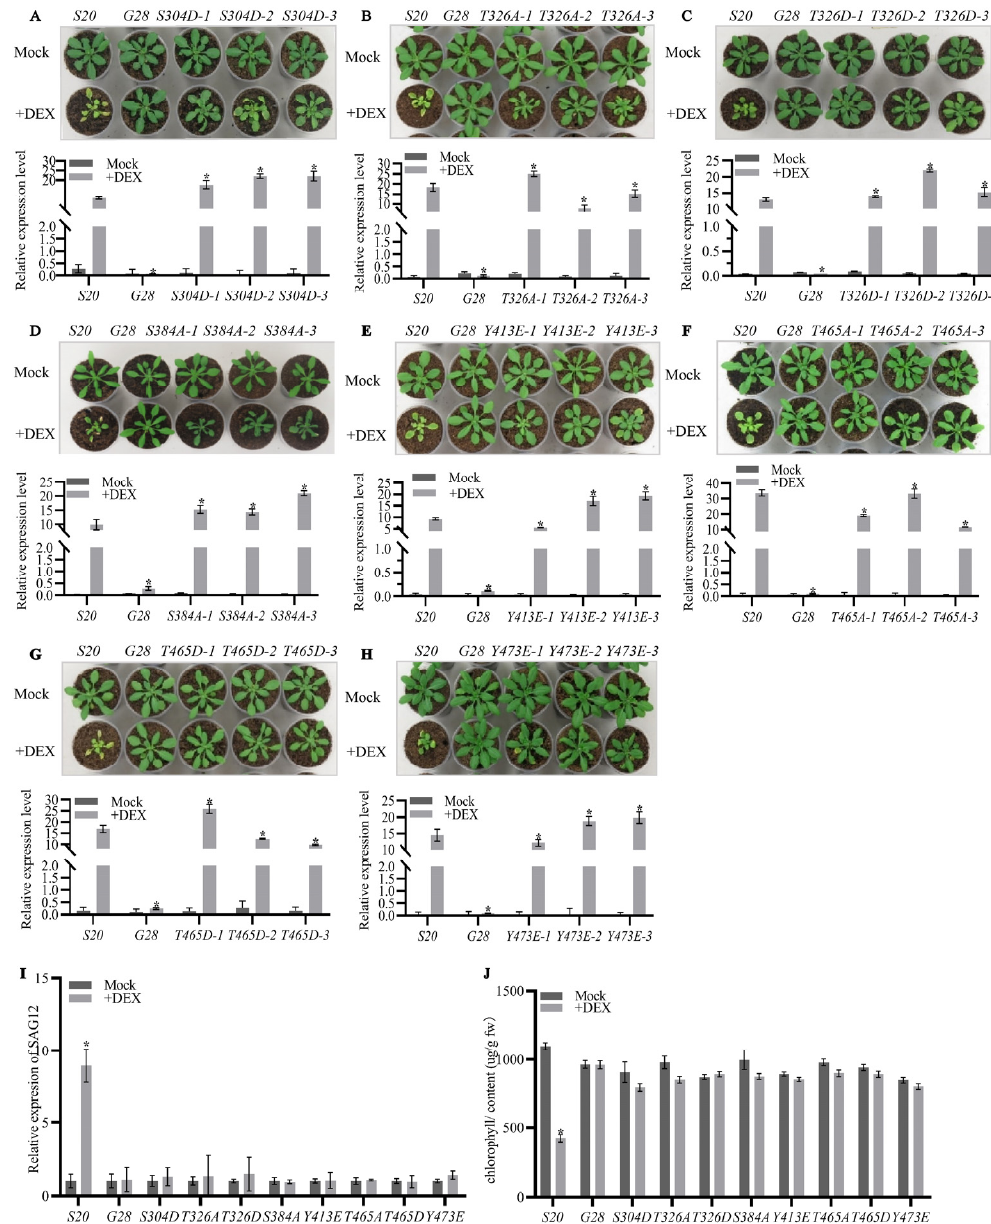
Figure 3. The autophosphorylation of AtSARK is essential for its function in promoting leaf senescence. Three independent lines of 19-d-old transgenic Arabidopsis overexpressing the indicated site-directed mutant of AtSARK under the control of GVG promoter were daily sprayed with dexamethasone (DEX) or its mock solvent as described in Section 4 and the photographs were taken after an additional 7 d (upper, A – H ). The GVG:AtSARK ( S20 ) and GVG:GUS ( G28 ) plants were used as positive and negative control, respectively. Relative transcript levels of the exogenous wild-type or mutated AtSARK gene in each transgenic line were evaluated by real-time quantitative RT-PCR (qPCR) using TIP41-Like as internal control (lower, A – H ). Data are means ± standard errors (SE) of three biological replicates. Stars indicate significant differences from DEX-treated S20 plants (student t ’-test, α = 0.05). ( I ) Transcript levels of the senescence-associated marker gene SAG12 in the fifth and six leaves of each transgenic line after DEX or mock treatment were determined at 24 h. ( J ) Chlorophyll contents in the fifth and sixth leaves of indicated transgenic plants were measured following the method described in materials and methods. Data are means ± SE of three biological replicates. Stars indicate significant differences from mock-treated control plants (student t ’-test, α =